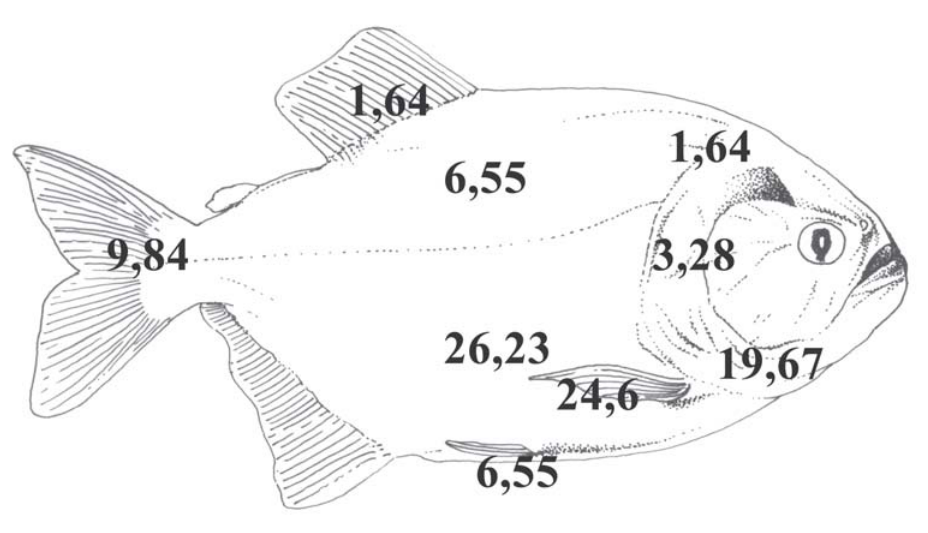
Fig. 1. Relative frequencies (%) of attachment sites of branchiurans on Pygocentrus nattereri (Serrasalminae) in the Amazon